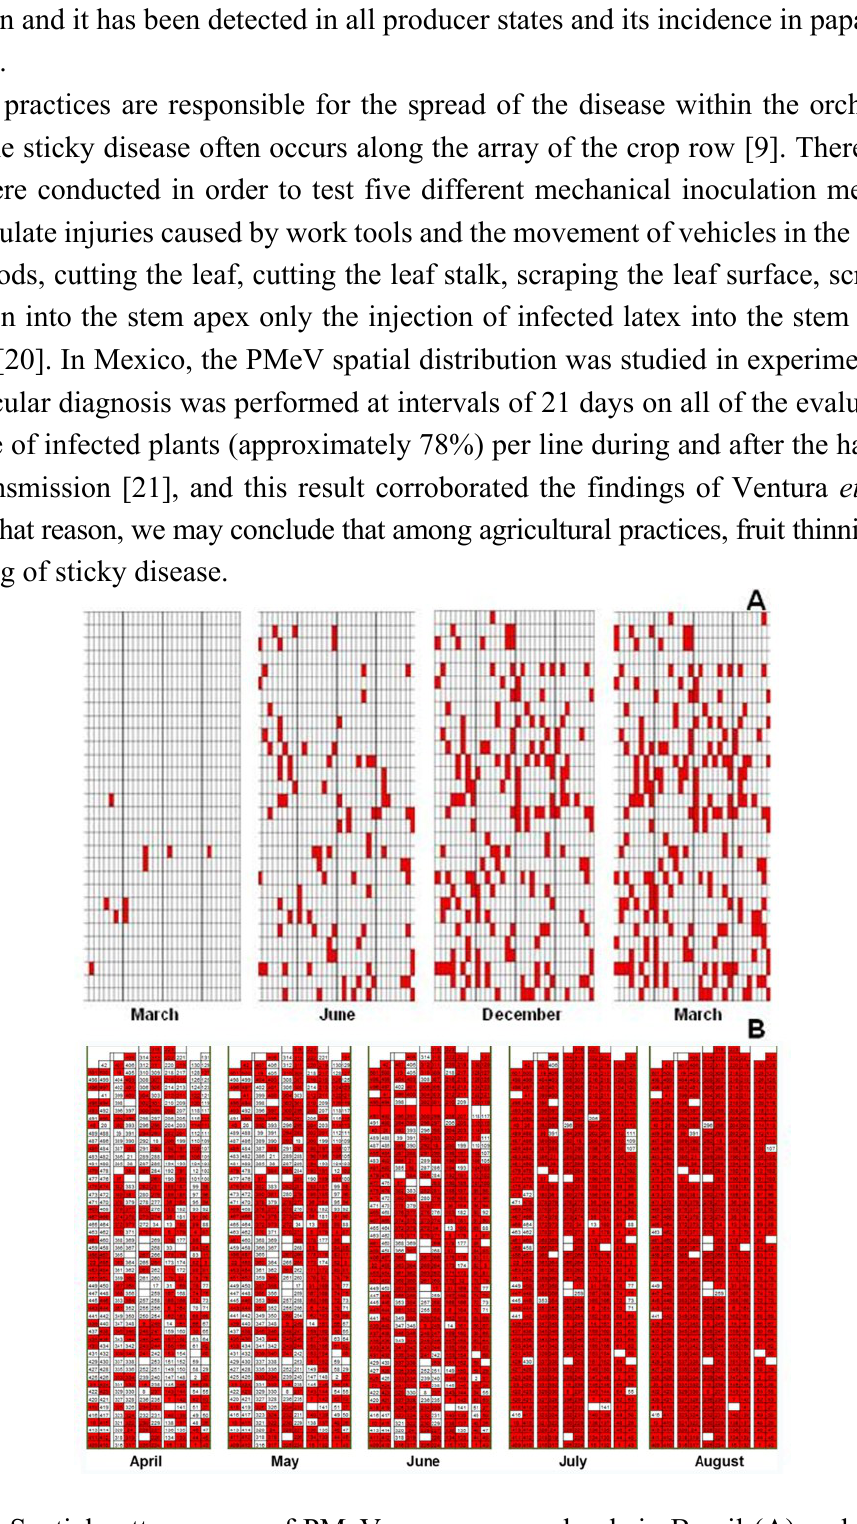
Figure 4. Spatial pattern maps of PMeV on papaya orchards in Brazil ( A ) and in Mexico ( B ). Red squares represent diseased plants and white represent healthy